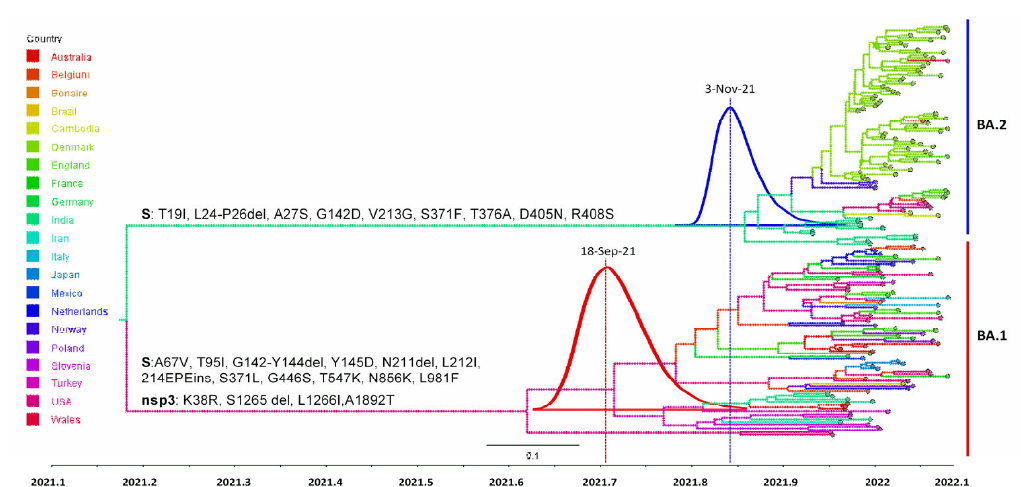
Figure 5. Time-resolved maximum clade credibility phylogeny of the Omicron BA.1 and BA.2 sub- lineages ( n = 161, sampled between November 2021 and January 2022). Mutations that characterize Omicron sub-lineages are indicated on the respective branches. The posterior distribution of the tMRCA for each sub-lineage is also shown. The countries as a trait for each sample are denoted by distinct colours.